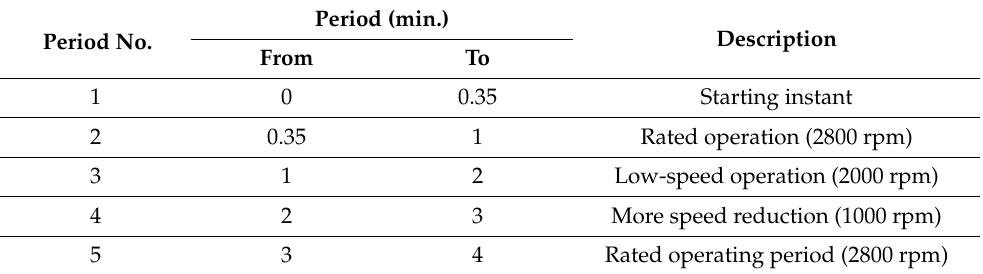
Table 3. Six-phase induction motor parameters. Parameter